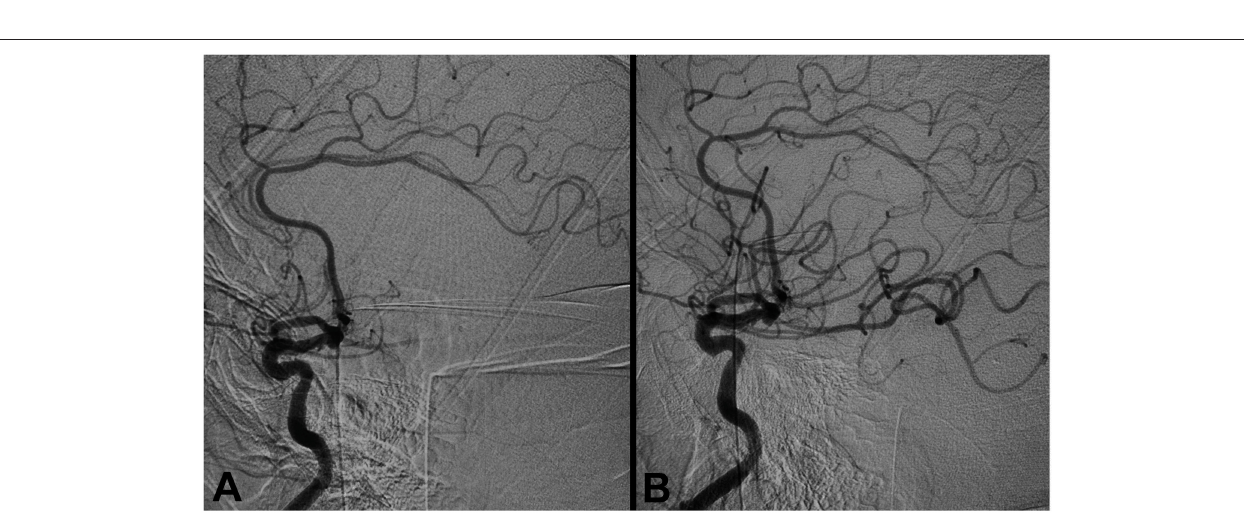
FIGURE 4 | Flow diverter deployment for right middle cerebral artery aneurysm. (A) Pre-procedure angiogram demonstrating right MCA aneurysm. (B) WEB flow diverter deployment, demonstrating successful deployment with conformity to the aneurysm walls. (C) Post-procedure angiogram demonstrating successful occlusion.